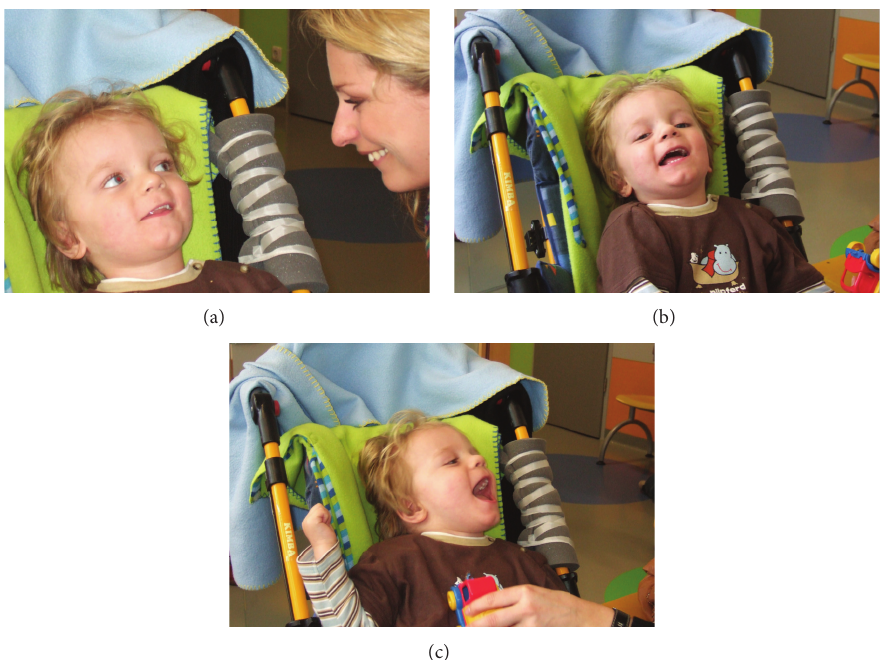
Figure 3: (a), (b), and (c) Two-months follow-up. (a) First social smiling of the patient (L.B.) towards his mother and (b, c) laughing, when played with, 2 months after autologous transplantation of cord blood cells (i.e., 4 months and one week after severe brain damage caused by cardiac